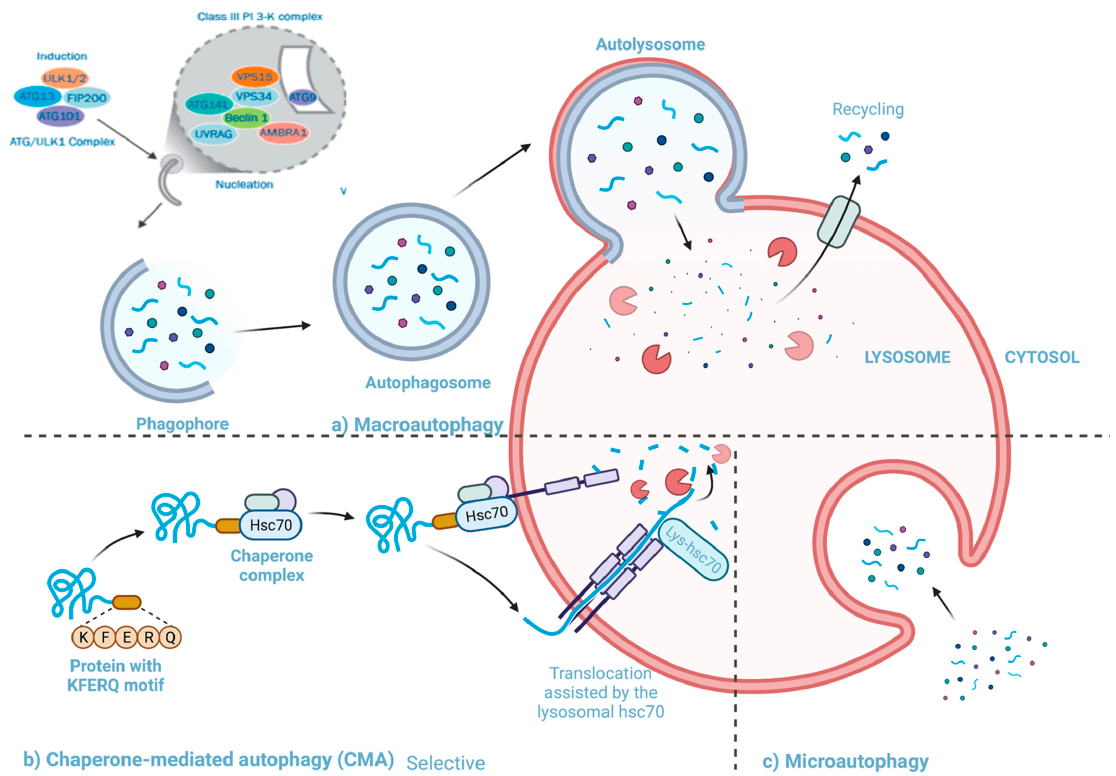
Figure 3. Three autophagy pathways ( a ) Macroautophagy: cytosolic material is transported to the lysosome using double membrane-bound vesicles which engulf the material and then fuse to the lysosome ( b ) Chaperone mediated autophagy: proteins bound to HSC70 being translocated to the lysosomal membrane to be unfolded and degraded. ( c ) Microautophagy: cytosolic components being directly taken up by the lysosome. Adapted from [60,61]. Created with BioRender.com